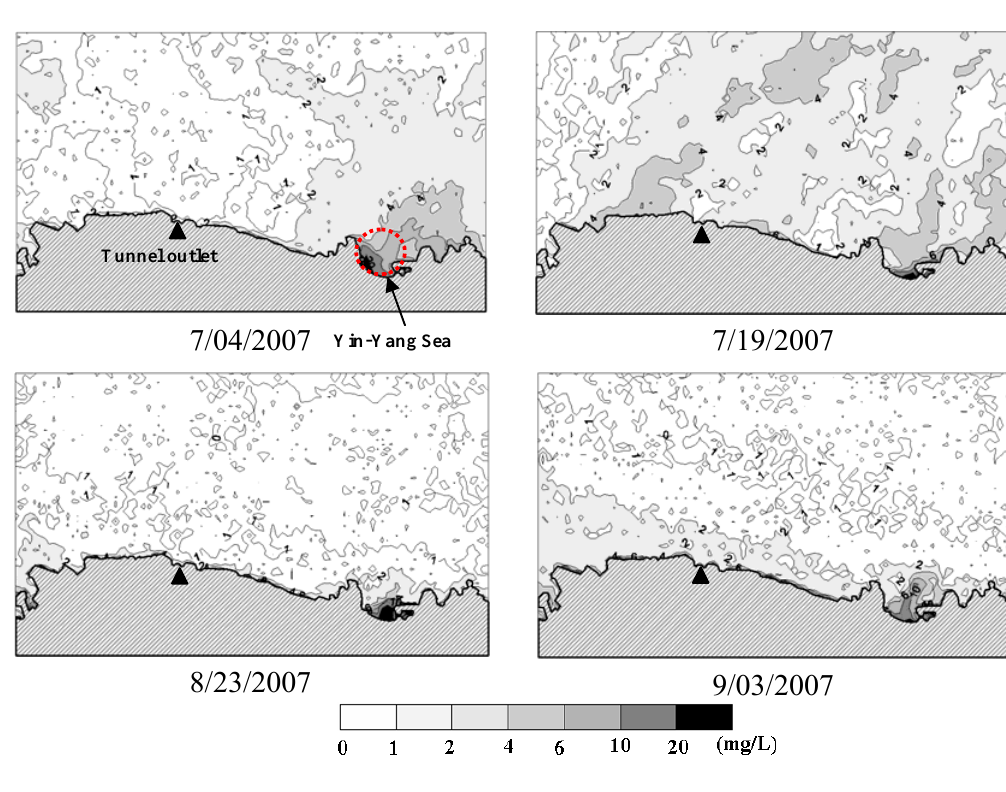
Figure 10. Spatial distribution of total suspended